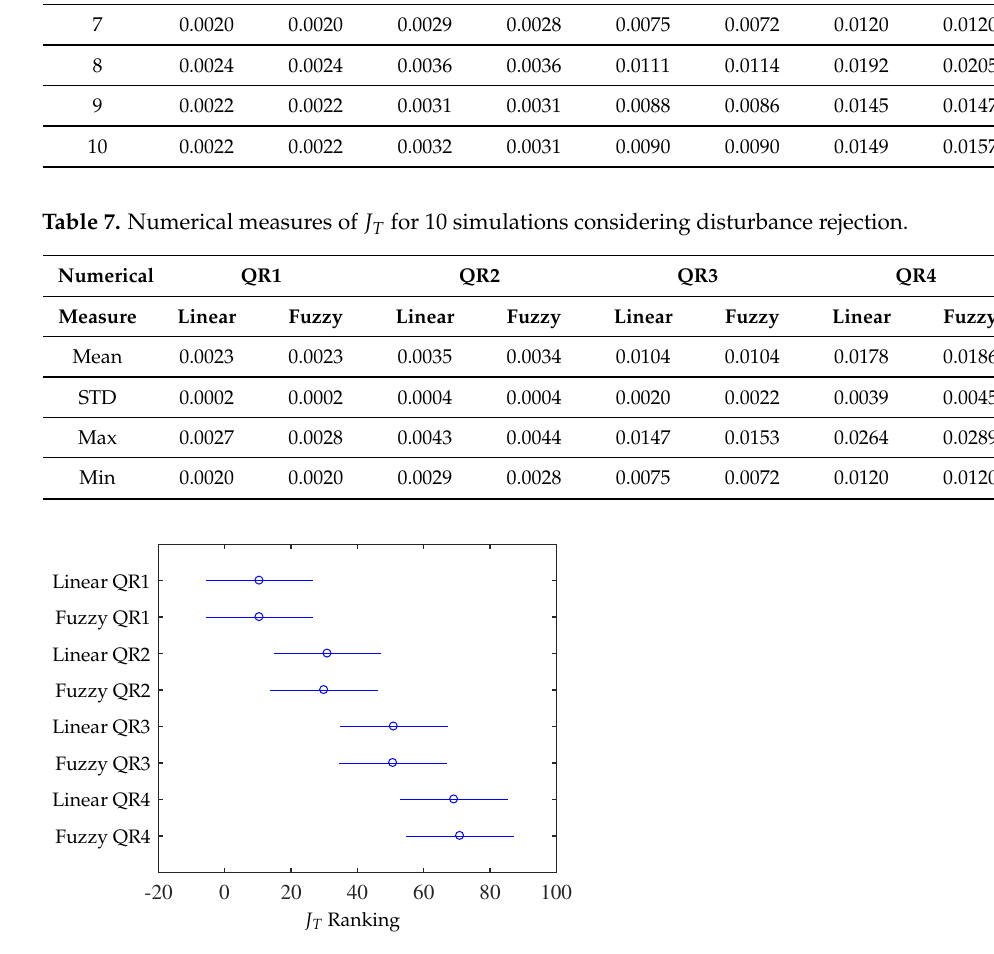
Figure 22. Multiple comparison using Bonferroni